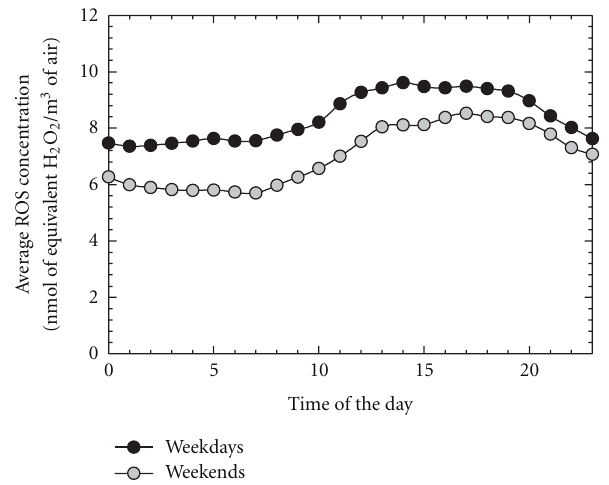
Figure 8: Diurnal variations of mean particle-bound ROS concen- trations measured on weekdays and weekends, respectively.